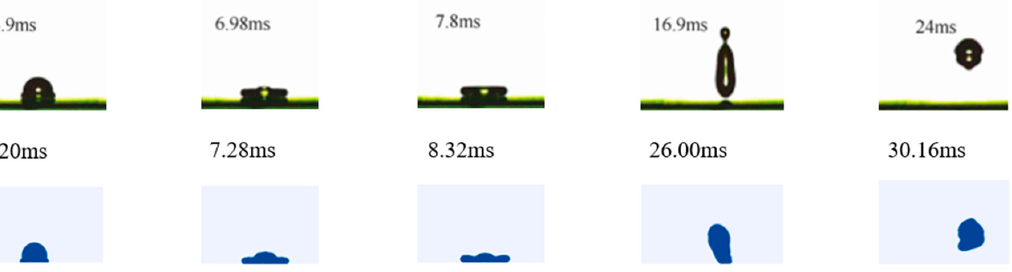
Figure 6. Comparison between numerical simulation and experimental results of Phase Transition Model.